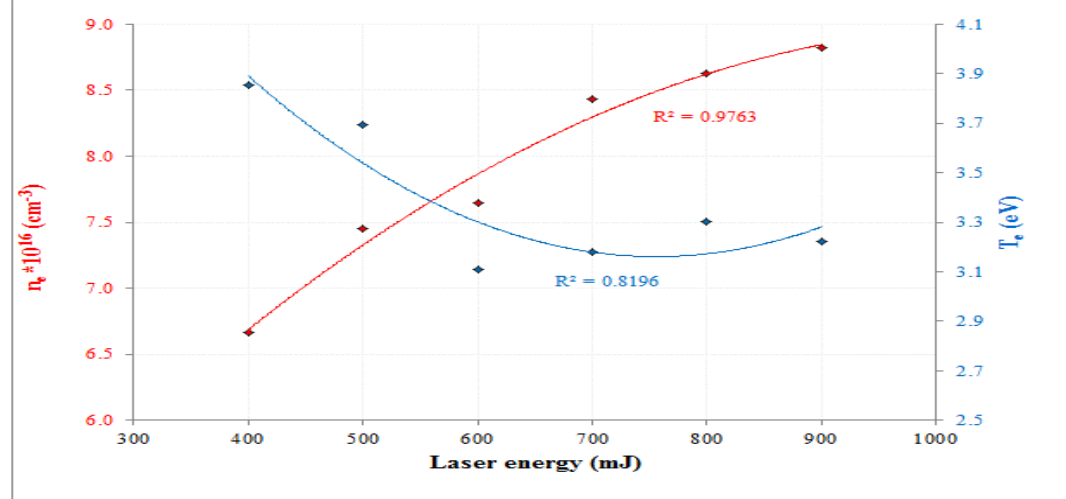
Fig. 11: The variation of T